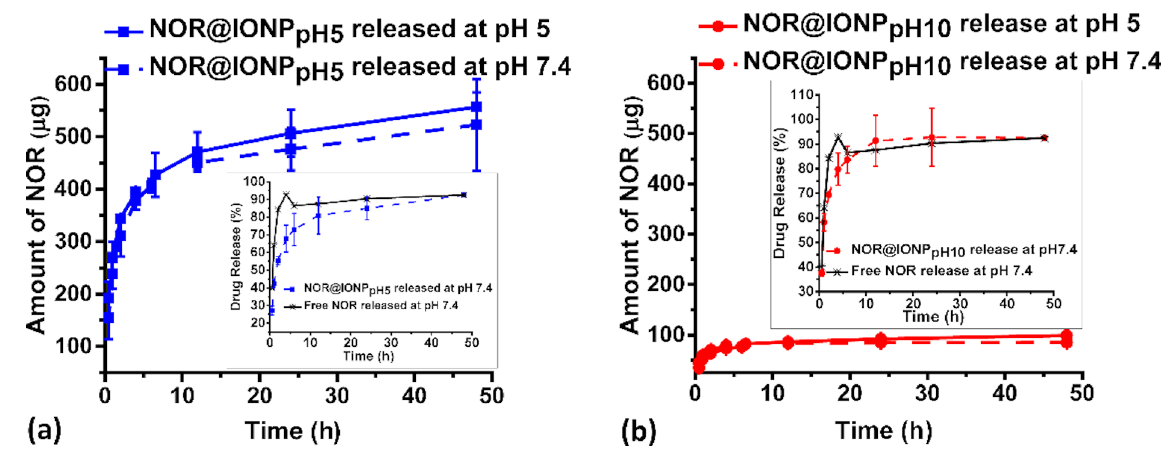
Figure 5: Drug release profile over 48 h (a) from NOR@IONP pH5 and (b) from NOR@IONP pH10 , where solid lines indicate a release in pH 5 medium, while the dashed lines indicate a release in a medium with pH 7.4. Insets depict percentage drug release for comparing the release of free drug and drug coated on nanoparticles (solid lines – for free drug, dashed lines – for nanoparticles). The standard deviation plotted for each data point is ob- tained from 3 replicates each.